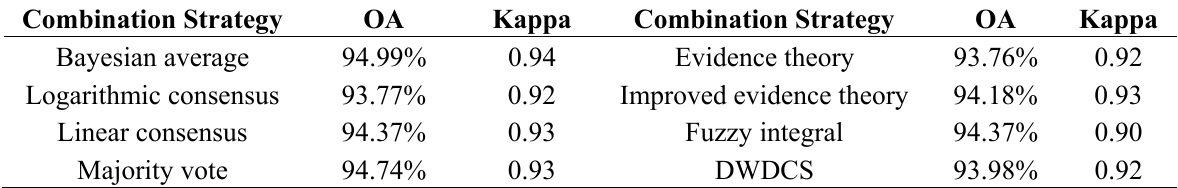
Table 2. Classification accuracy of parallel classifier